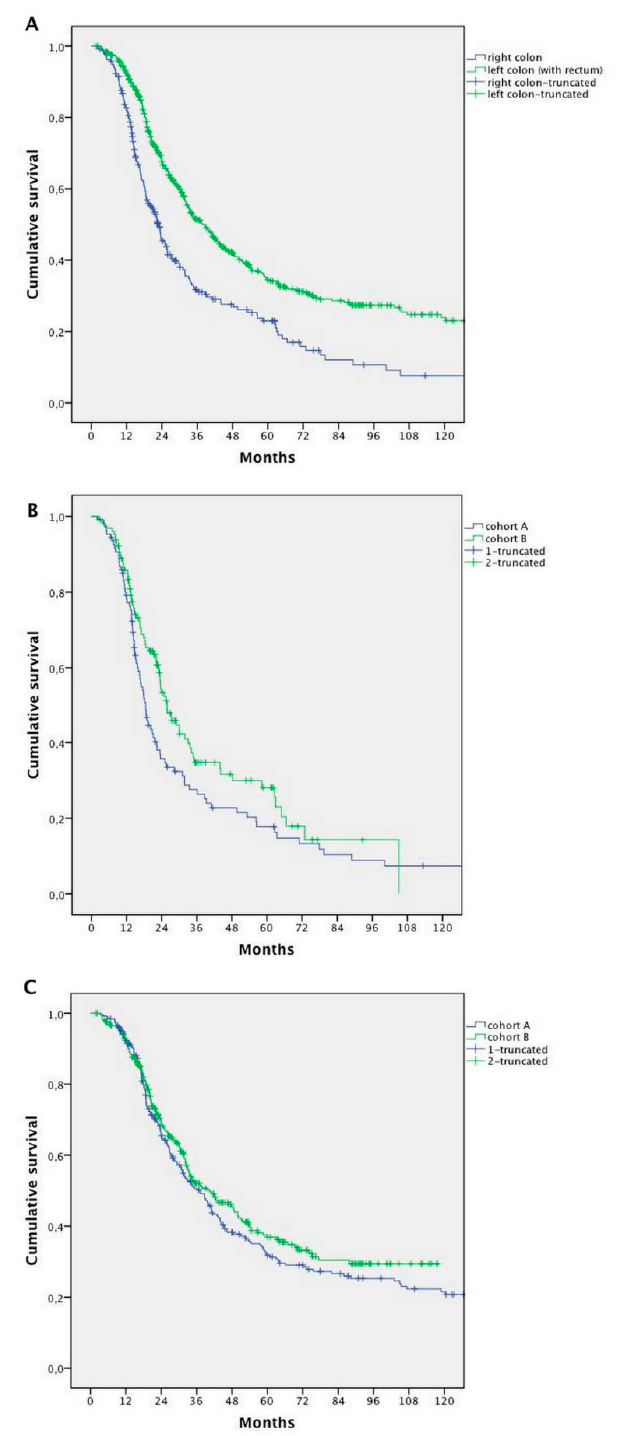
Figure 4. Survival analysis according to the primary tumor site: ( A ) survival analysis of patients with right-sided primary tumor vs. left-sided primary tumor (whole population); ( B ) survival analysis for patients with right-sided primary tumor in Cohort A vs. Cohort B; and ( C ) survival analysis for patients with left-sided primary tumor in Cohort A vs. Cohort